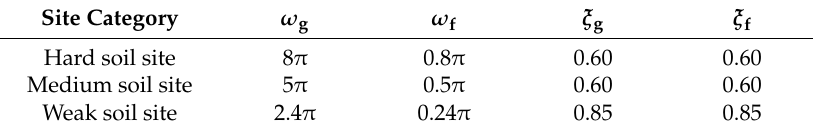
Table 2. Values of C-P model parameters [24,25].